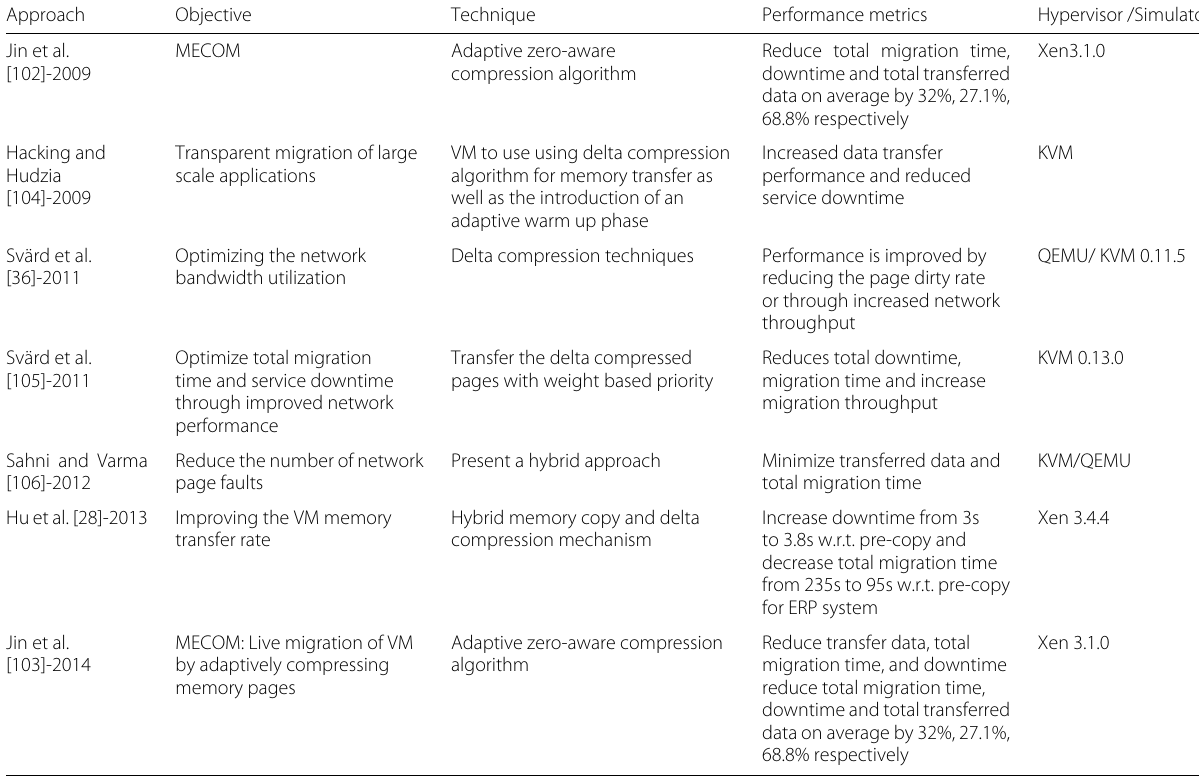
Table 9 Comparison of Compression based VM migration approaches